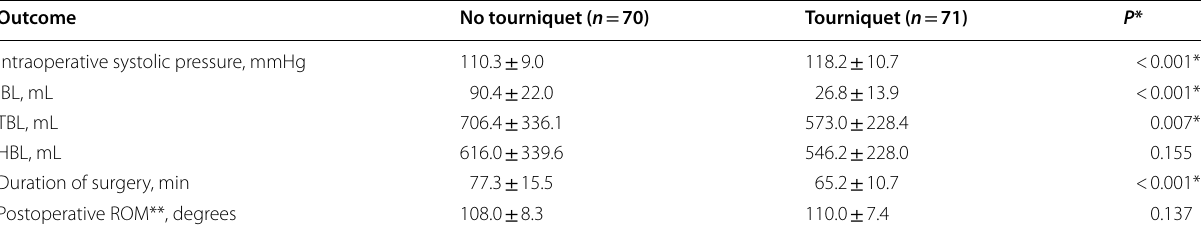
Table 2 Comparison of blood loss, intraoperative systolic pressure, operating time, and postoperative ROM between the two groups